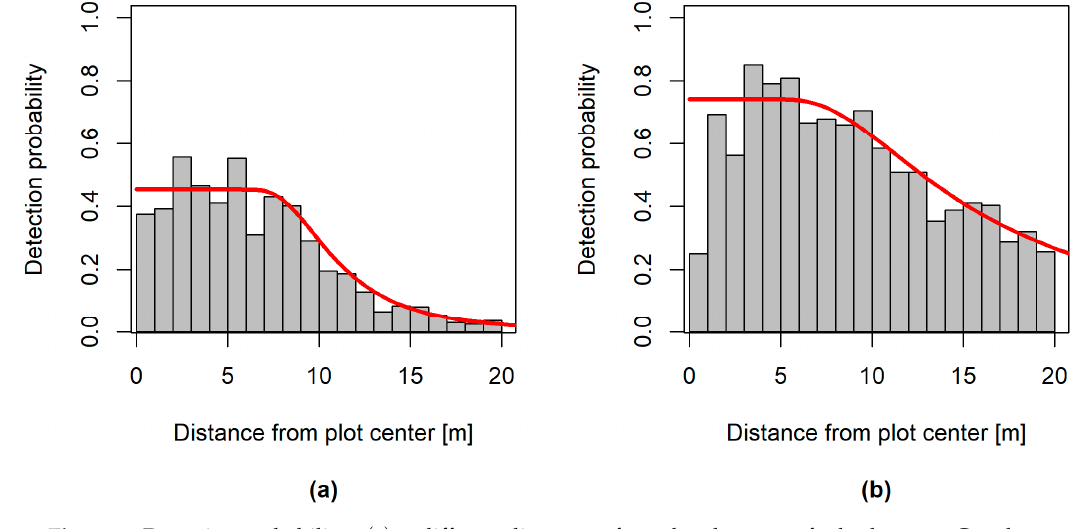
Figure 2. Detection probability g ( r ) at di ff erent distances r from the plot center for both strata. Grey bars represent the observed detection probabilities, and the fitted hazard rate-type models g hr ( r ) are shown as red curves. ( a ) Small trees (5 cm ≤ dbh < 20 cm) and ( b ) large trees (dbh ≥ 20 cm). Table 3. Parameter estimates for the extended hazard rate-type detection function for both strata.